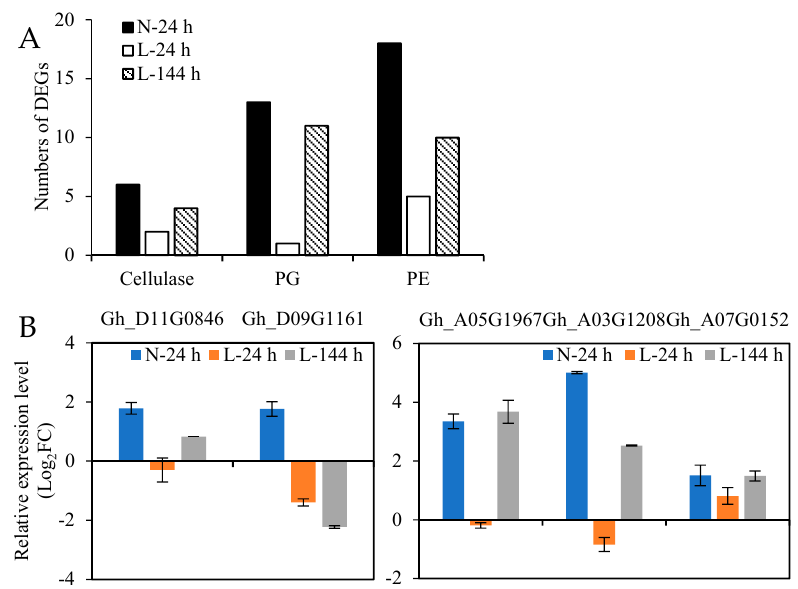
Figure 8. The expression of cell wall hydrolase genes in AZs treated with TDZ at different temper- atures. ( A ) Numbers of upregulated cell wall hydrolase genes in AZs treated with TDZ; ( B ) the expression levels of selected cell wall hydrolase genes from RT-qPCR.